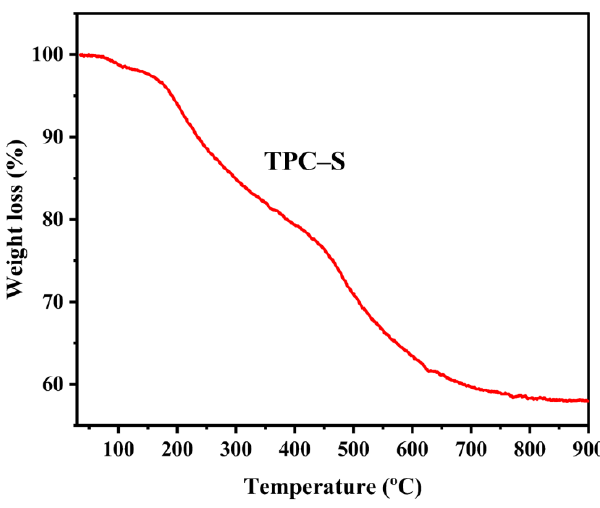
Figure 6. The TG curve of TPC – S.